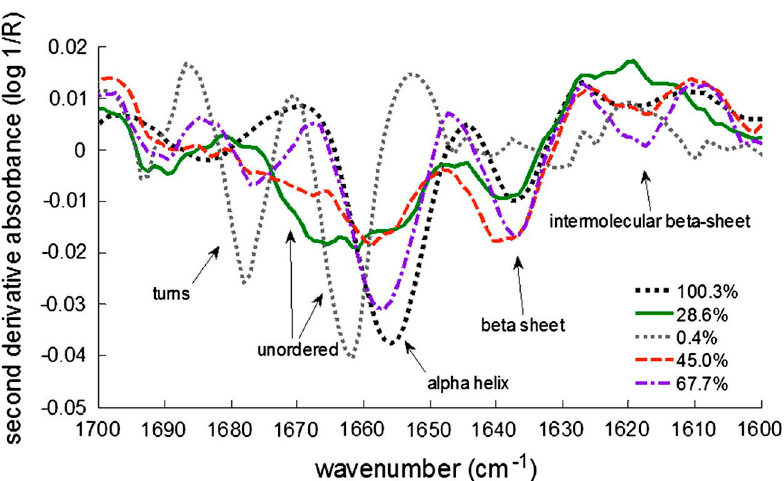
Figure 2. Second derivative FTIR (fourier transform infrared) spectra of lyophilized lactate dehydrogenase (LDH). Different types of secondary structures are shown, as well as different % of remaining LDH activity after reconstitution. Reproduced with permission from [24], Elsevier, 2013.